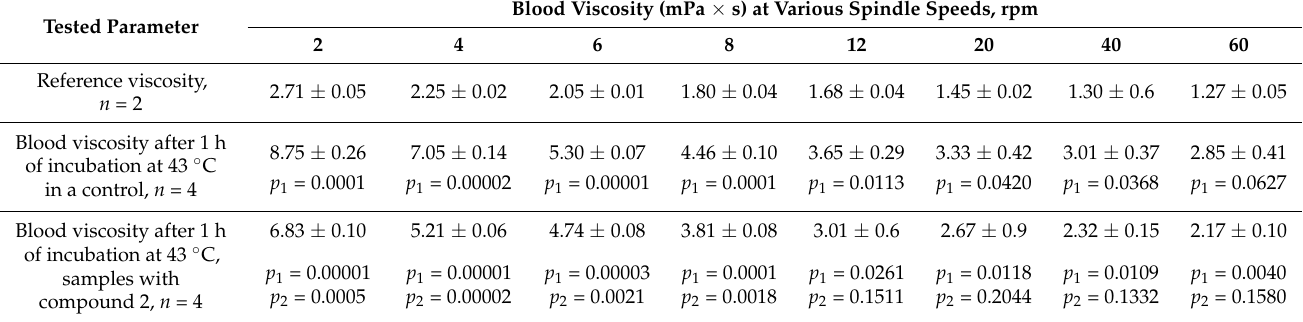
Table 5. Effect of compound 2 on blood viscosity (mPa × s) at various spindle speeds in the in vitro model of blood hyperviscosity.